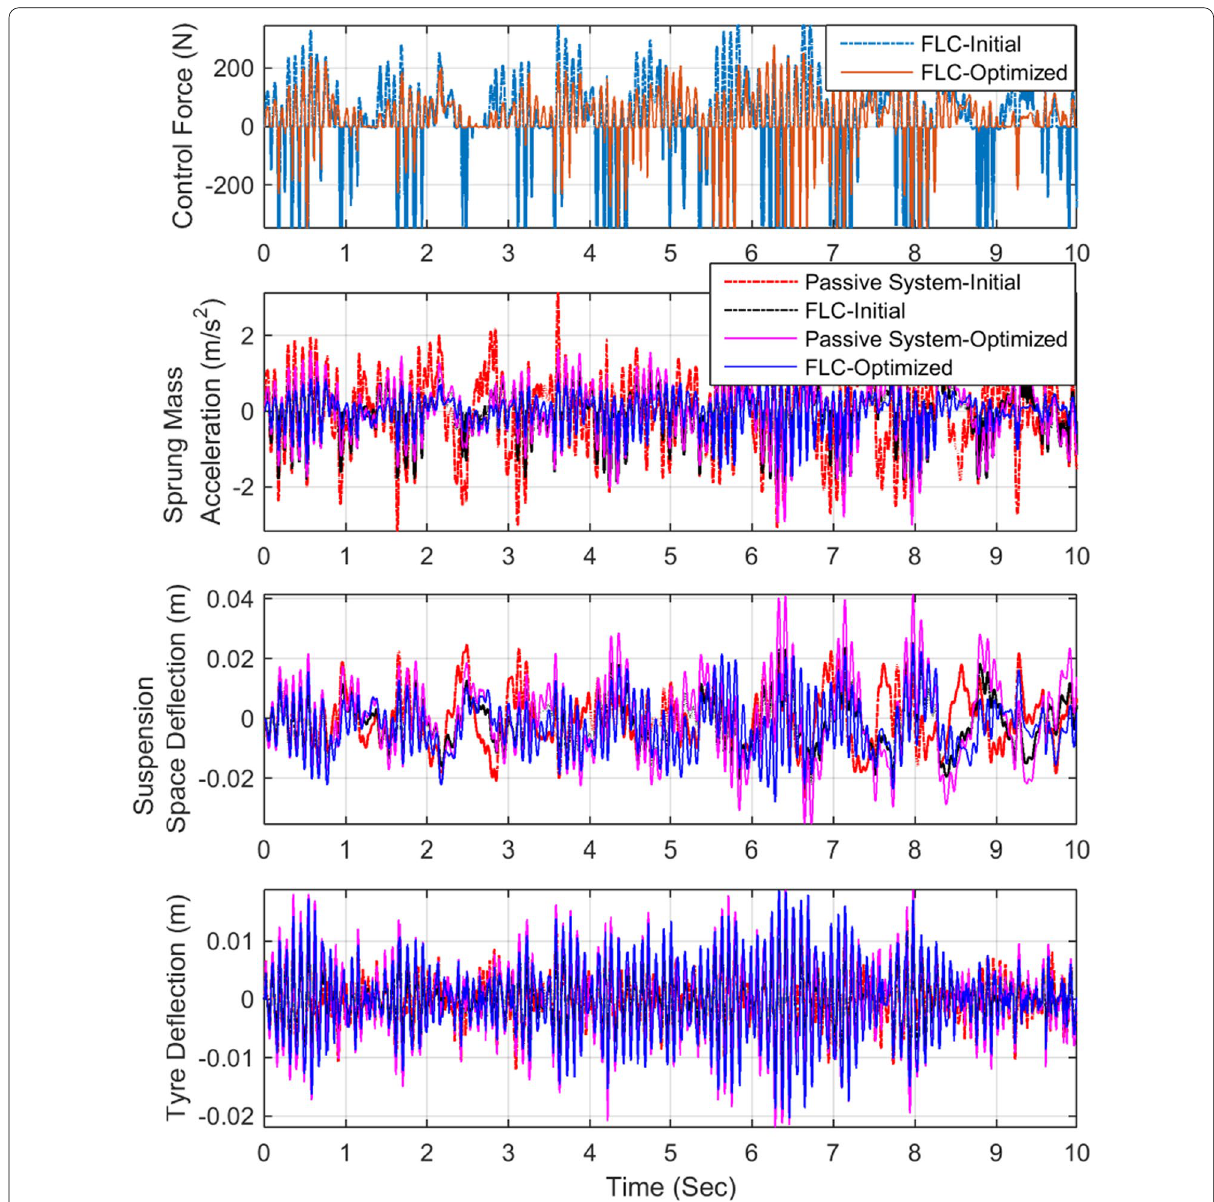
Fig. 10 Time domain results—all combined